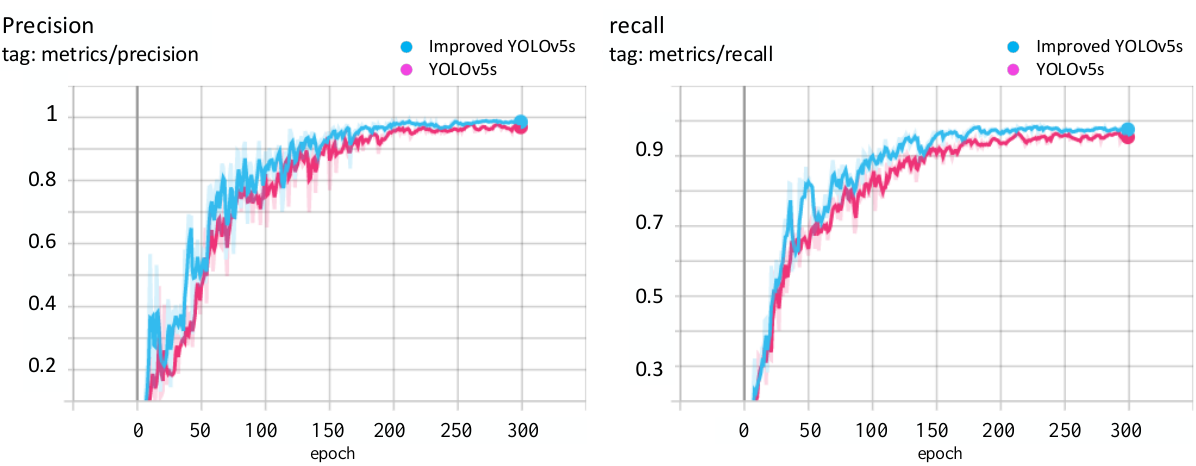
Figure 8. Comparison chart of mAP_0.5 and mAP_0.5:0.95.